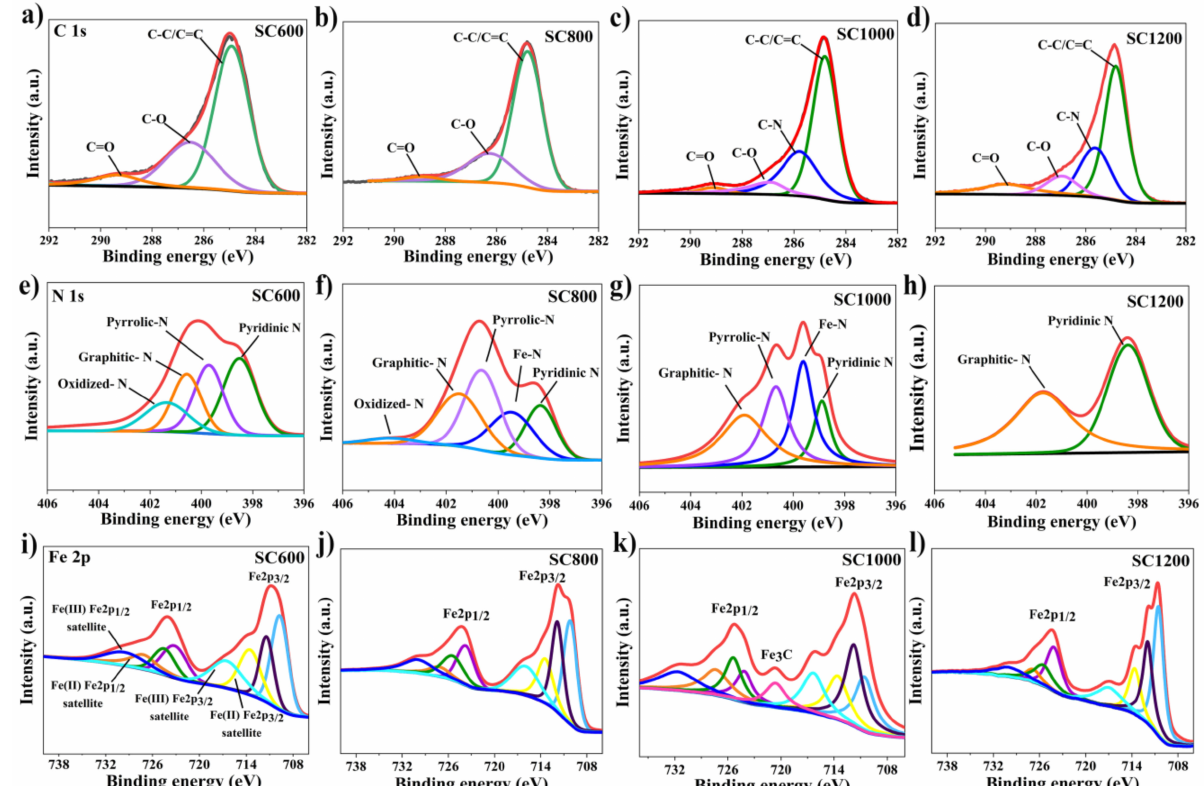
Figure 4. C1s spectra for ( a ) SC600, ( b ) SC800, ( c ) SC1000 and ( d ) SC1200; N1s spectra for ( e ) SC600, ( f ) SC800, ( g ) SC1000 and ( h ) SC1200; Fe2p spectra for ( i ) SC600, ( j ) SC800, ( k ) SC1000 and ( l )